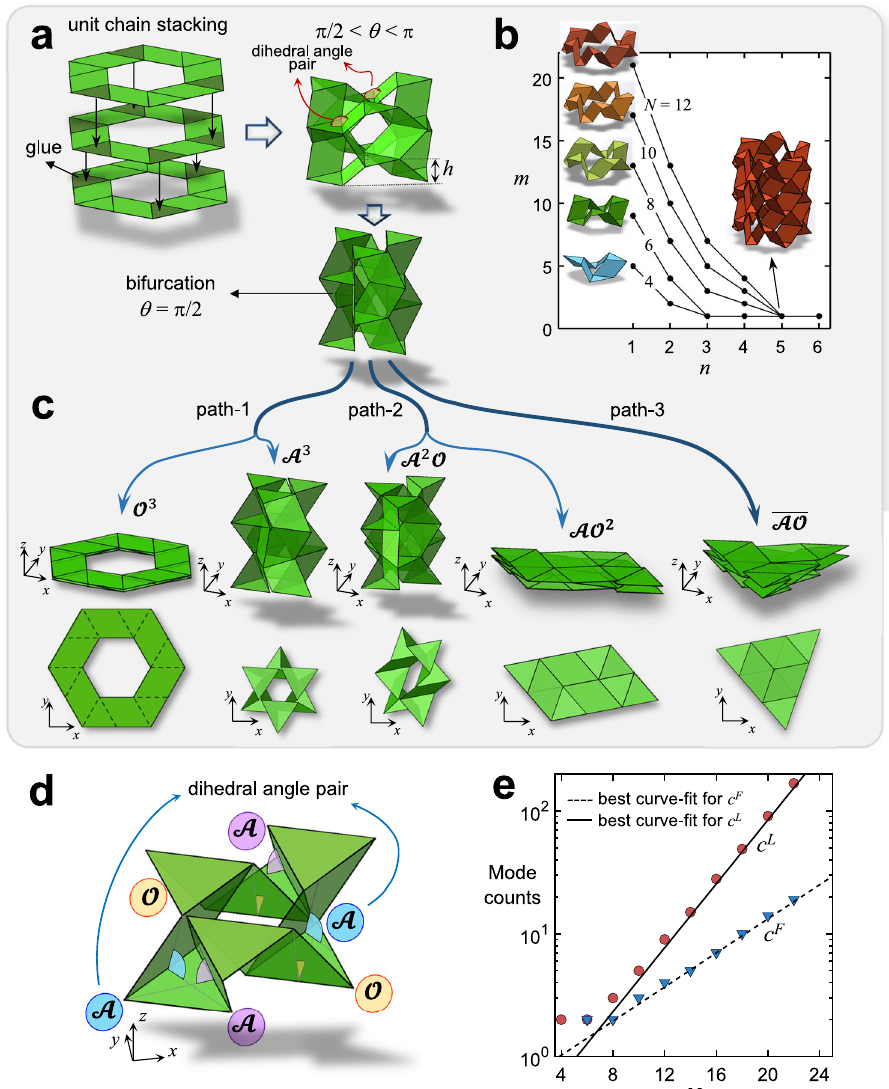
Fig. 2 Multiple kinematic paths leading to lockable and fl at-foldable modes. a Unit chain stacking for a three-layered unit ^ N 6 n 3 . On its right, a representative pre-bifurcation recon fi guration with θ < π (above) and the bifurcation state with θ = π /2 (below). b Pre-bifurcation DoFs, m , plotted as a function of the number of stacked layers, n , for given N even-sided primitives ( N = 4, 6, 8, 10, 12). c Isometric and top views of fi ve post-bifurcation modes belonging to three kinematic paths: four regular modes, of which two are locked ( A 3 and A 2 O ) and two fl at-folded ( O 3 and AO 2 ), and one irregular mode ( (cid:1) AO ) . d Zoom on the top layer of ^ N 6 n 3 in lock mode A 2 O showing the arrangement of pairs of valley dihedral angles (in color): Three pairs of dihedral angles are illustrated here, two A s (violet and blue) and one O (yellow) for a total of six dihedral angles. e Mode counts calculated from discrete data points for N > 4 along with the best curve fi ts characterizing the number of fl at-foldable c F and lockable c L modes vs. N for a generic multilayered unit N N n (cid:1) n (semi-log plot). (Denomination of the dihedral angles and modes: We specify acute angles with A and obtuse angles with O : The geometry of the units enforces the condition A þ O ¼ π during their entire range of motion. Since in N N n (cid:1) n , which has one DoF, each pair contains equal angles, all A s are equal as are all O s. A given sequence with angle pairs, e.g., two A s and one O depicted in d , can be simply denoted by the series of angle pairs, e.g., AAO , and in compact form with the power indicating the repeated pairs, e.g., A 2 O Notions of crystallography become handy to study changes in symmetry. Each pattern is formed by tessellating in-plane a representative unit (red boundaries in Fig. 3) de fi ned by the periodic vectors. Upon recon fi guration, the material system at bifurcation can access a new kinematic path that causes the smooth transition of certain dihedral angle pairs from A to O ; the result is a break in symmetry. This phenomenon is visualized by the patterns that followed those in the fi rst column of Fig. 3, each denoted by their crystallographic point group and Schoen fl ies symbol. A variation in the lattice point groups translates into a change of the elastic constants de fi ning the elastic tensor; the